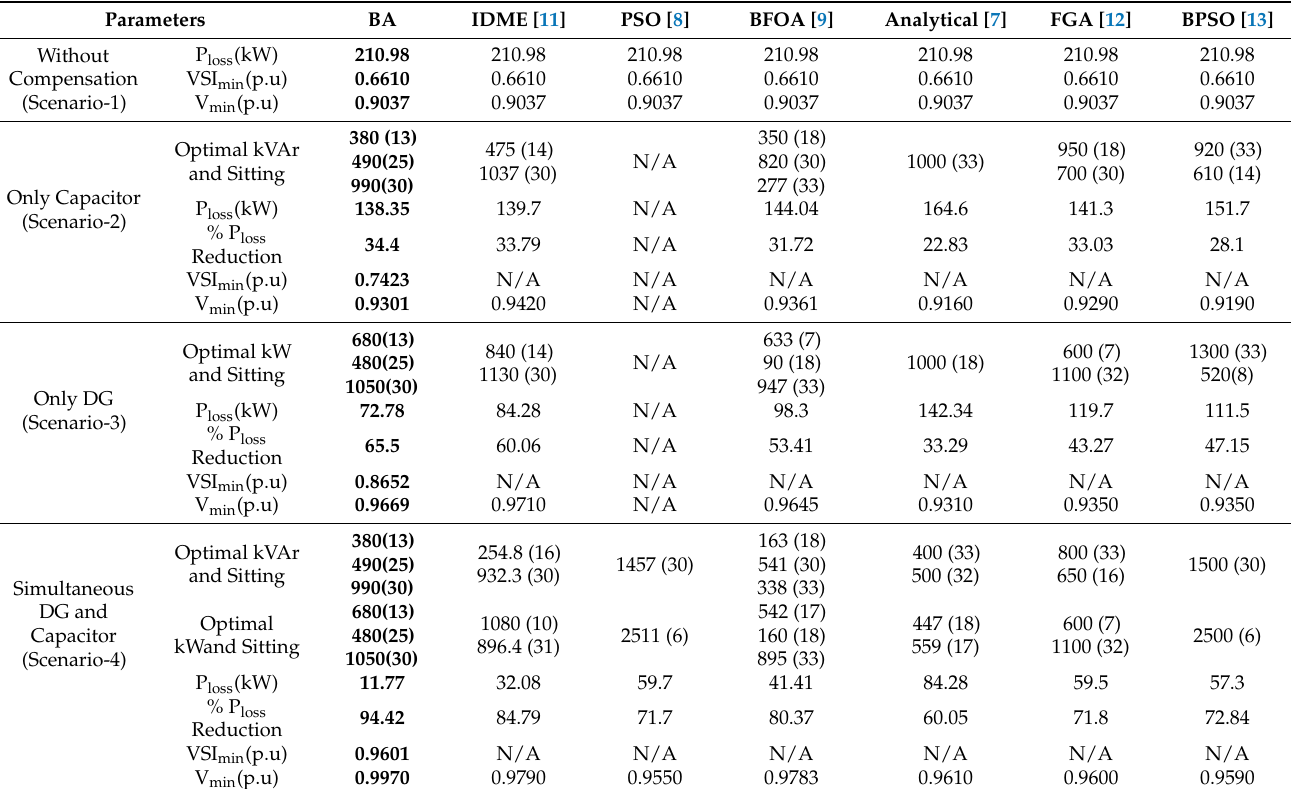
Table 4. Results of IEEE 33 RDS (Constant Load Model).